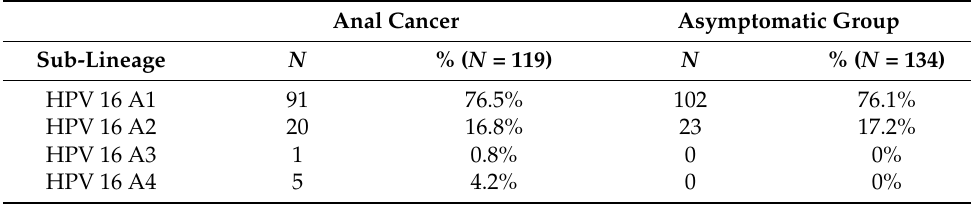
Table 2. HPV 16 sub-lineages identified in the anal cancer and asymptomatic